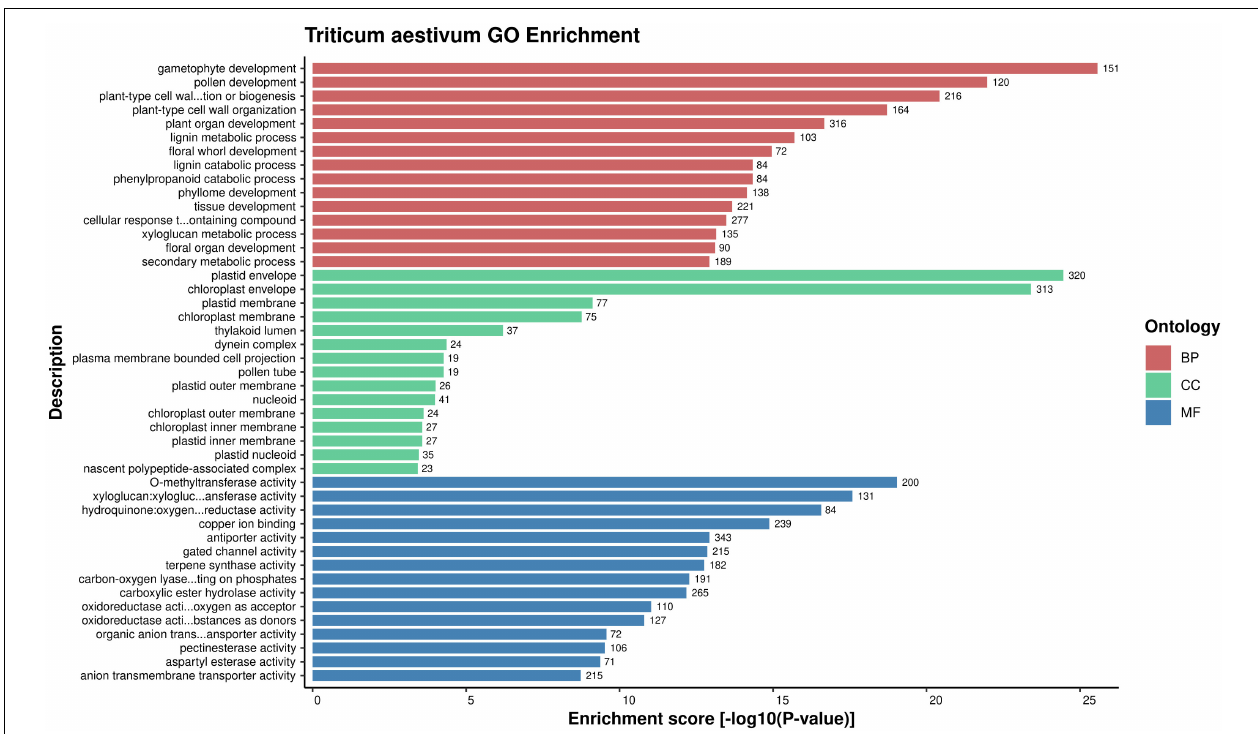
FIGURE 2 | Over-representation of top 15 GO terms from each category (molecular function, cellular component, and biological process) for the host proteins, based on enrichment score.